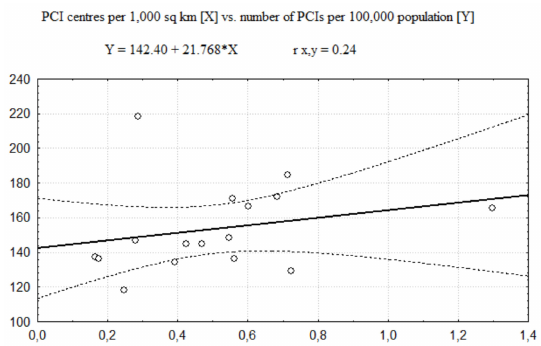
Figure 6. The regression function of PCI centres number per 1000 km 2 vs. number of PCIs per 100,000